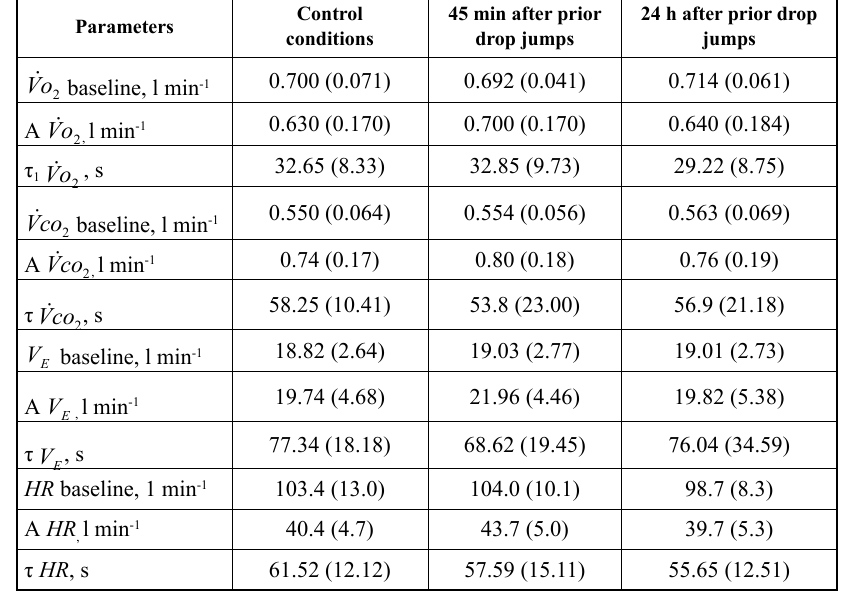
Keywords: Delayed onset muscle soreness, oxygen uptake, constant load. Figure 2. Group mean response of pulmonary ventilation ( V E ) during